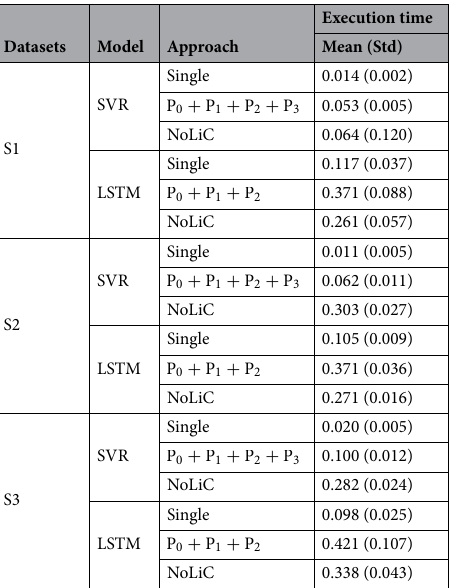
Table 8. Testing time in seconds of the single models and combination approaches for 1 day ahead forecasting. For each approach is presented the mean testing time and the respective standard deviation.